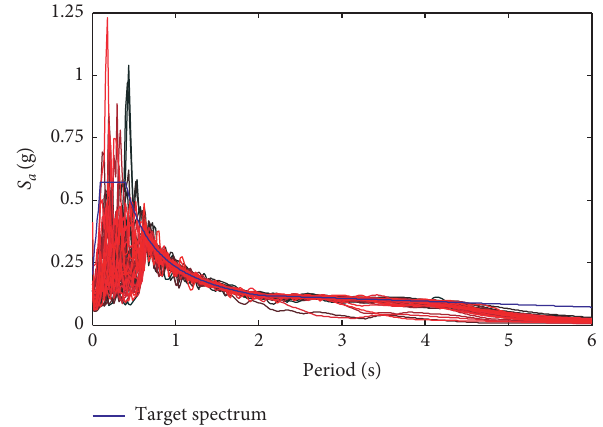
Figure 5: Spectrally matched spectra and target